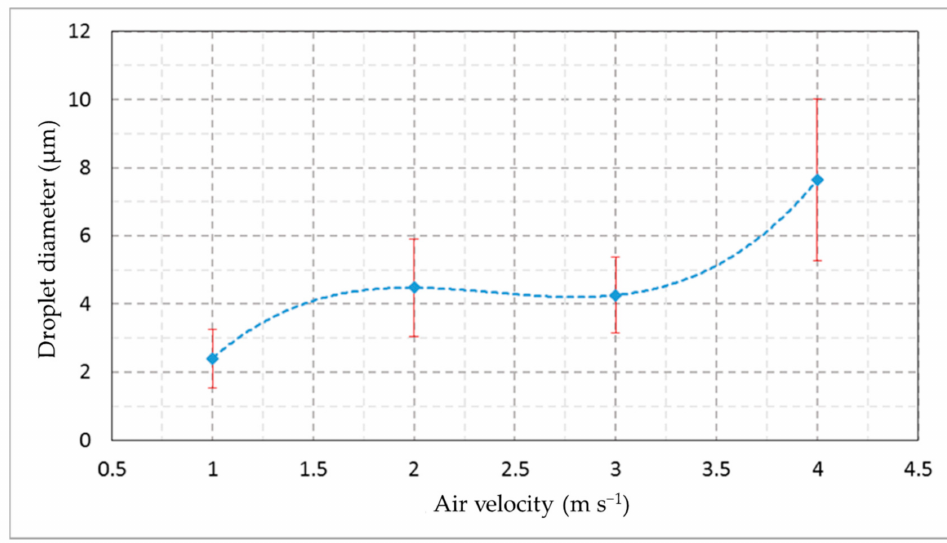
Figure 8. The relationship between air velocity at the outlet of the ultrasonic humidifier ducts and mean values of droplet diameter measured under RH of 80% and temperature of 5 ◦